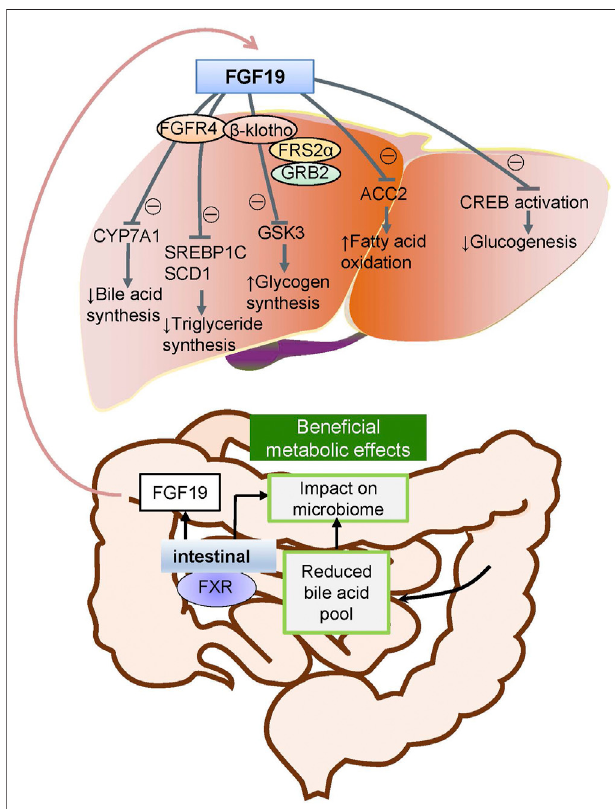
FIGURE 2 | Metabolic pathways of FGF19 during normal conditions. Under normal conditions, FGF19 is secreted from the intestinal canal and enters into the enterohepatic circulation into the liver and subsequently binds to the speci fi c receptor activating the FGF19/klotho/FGFR4 pathways. This results in the metabolic regulation of glucogenesis, fatty acid oxidation, glycogen synthesis, triglyceride synthesis, and bile acid synthesis.